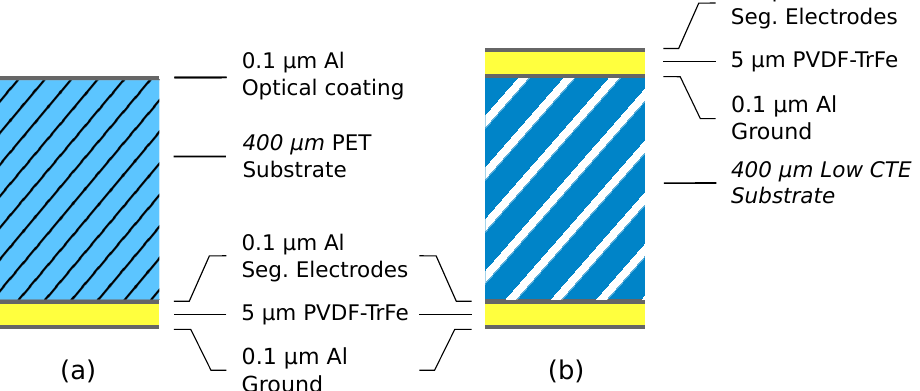
Figure 7. Layer distribution used in the numerical simulation ( a ) unimorph design; ( b ) balanced